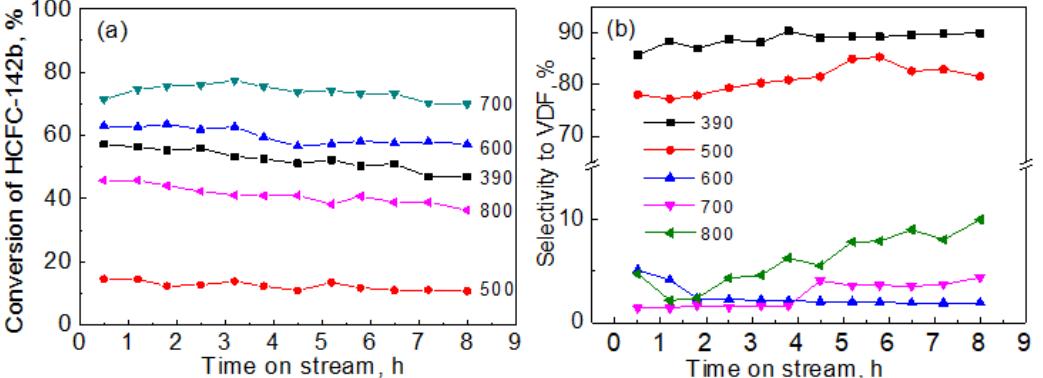
Figure 3. Effect of calcination temperature on the catalytic performance of SrF 2 @C catalysts for the decomposition of HCFC-142b. ( a ) Conversion of HCFC-142b and ( b ) selectivity to VDF. Reactions were carried out at 350 ° C, 1 bar, GHSV (HCFC-142b) of 600 h −1 with N 2 :HCFC-142b of 1:1.